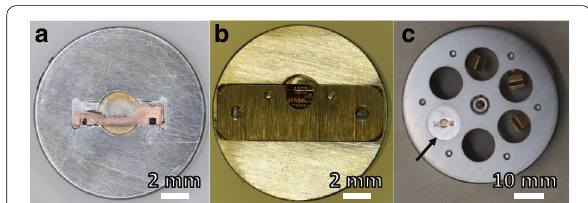
Fig. 3 Pictures of the Kochi subsample holder for the nanoscale secondary ion mass spectrometer (NanoSIMS): a a NanoSIMS subsample holder for the Kochi grid, b a NanoSIMS subsample holder for the Kochi clamp, and c a commercial NanoSIMS holder with a subsample holder for Kochi